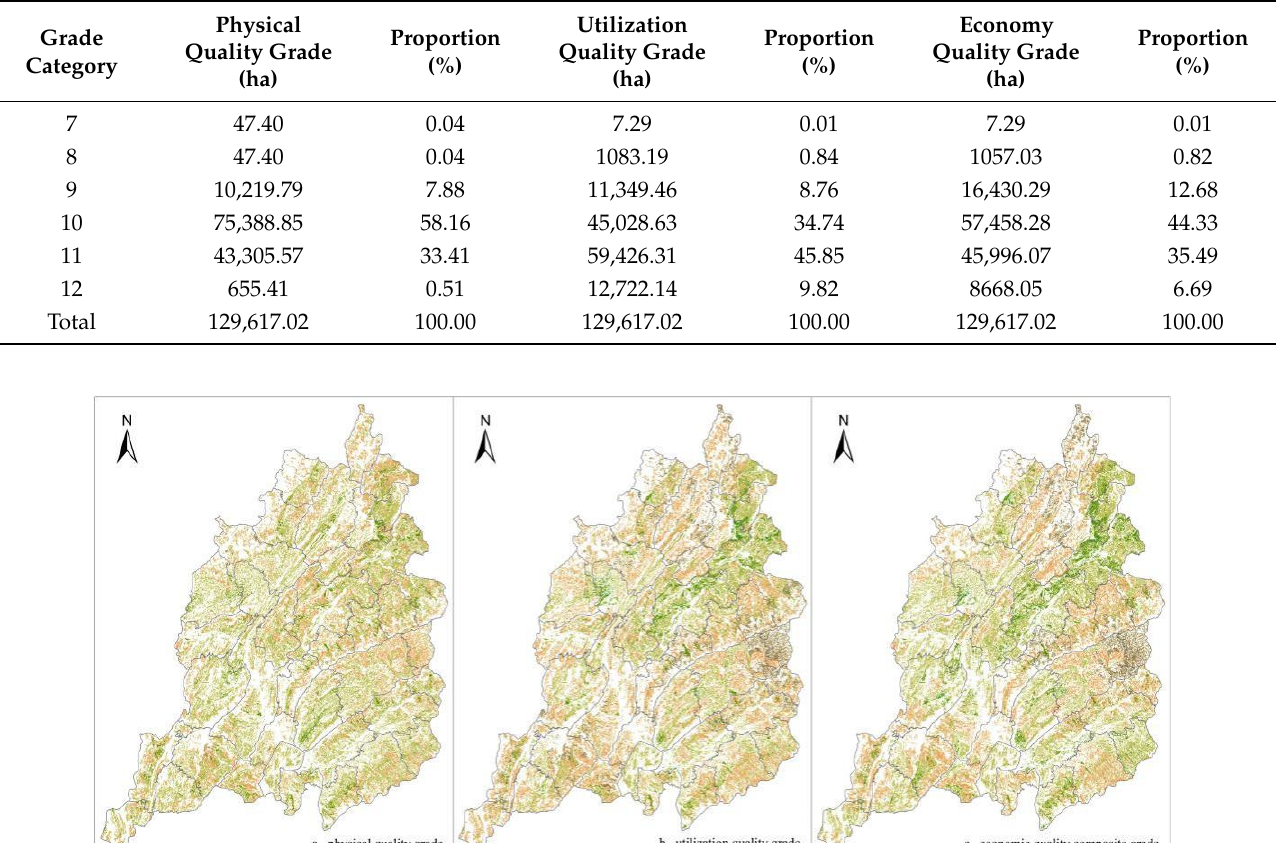
Table 2. Classified statistics of cultivated landquality grade area in Pengshui County.